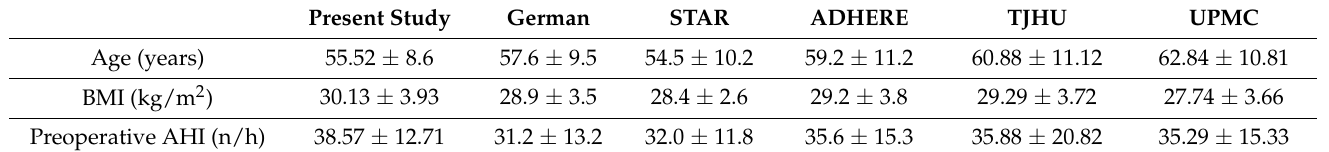
Table 3. Demographic variables comparing main Hypoglossal Nerve Stimulation studies